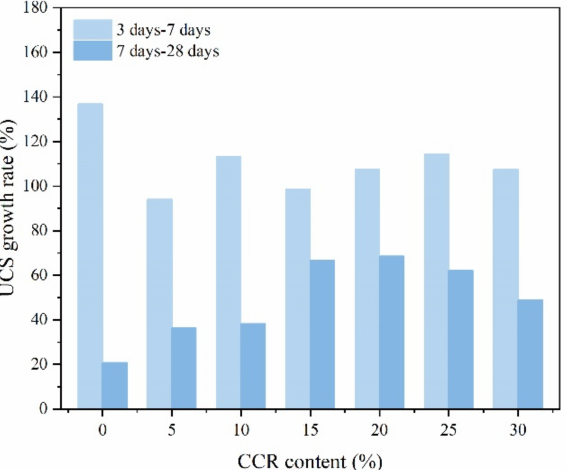
Figure 8. The UCS gr(3–7) and UCS gr(7–28) of CPDS versus the CCR content at 30% cement